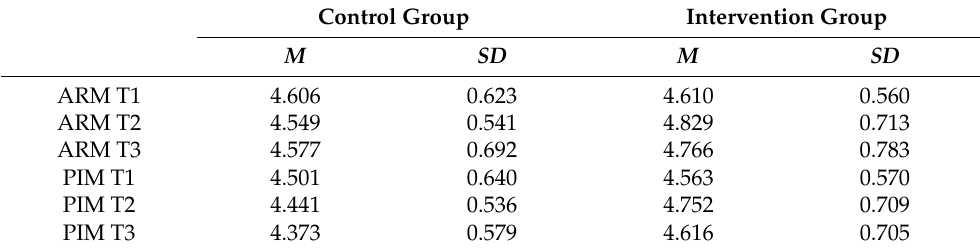
Table 2. Descriptive statistics at different time points in Study 2.